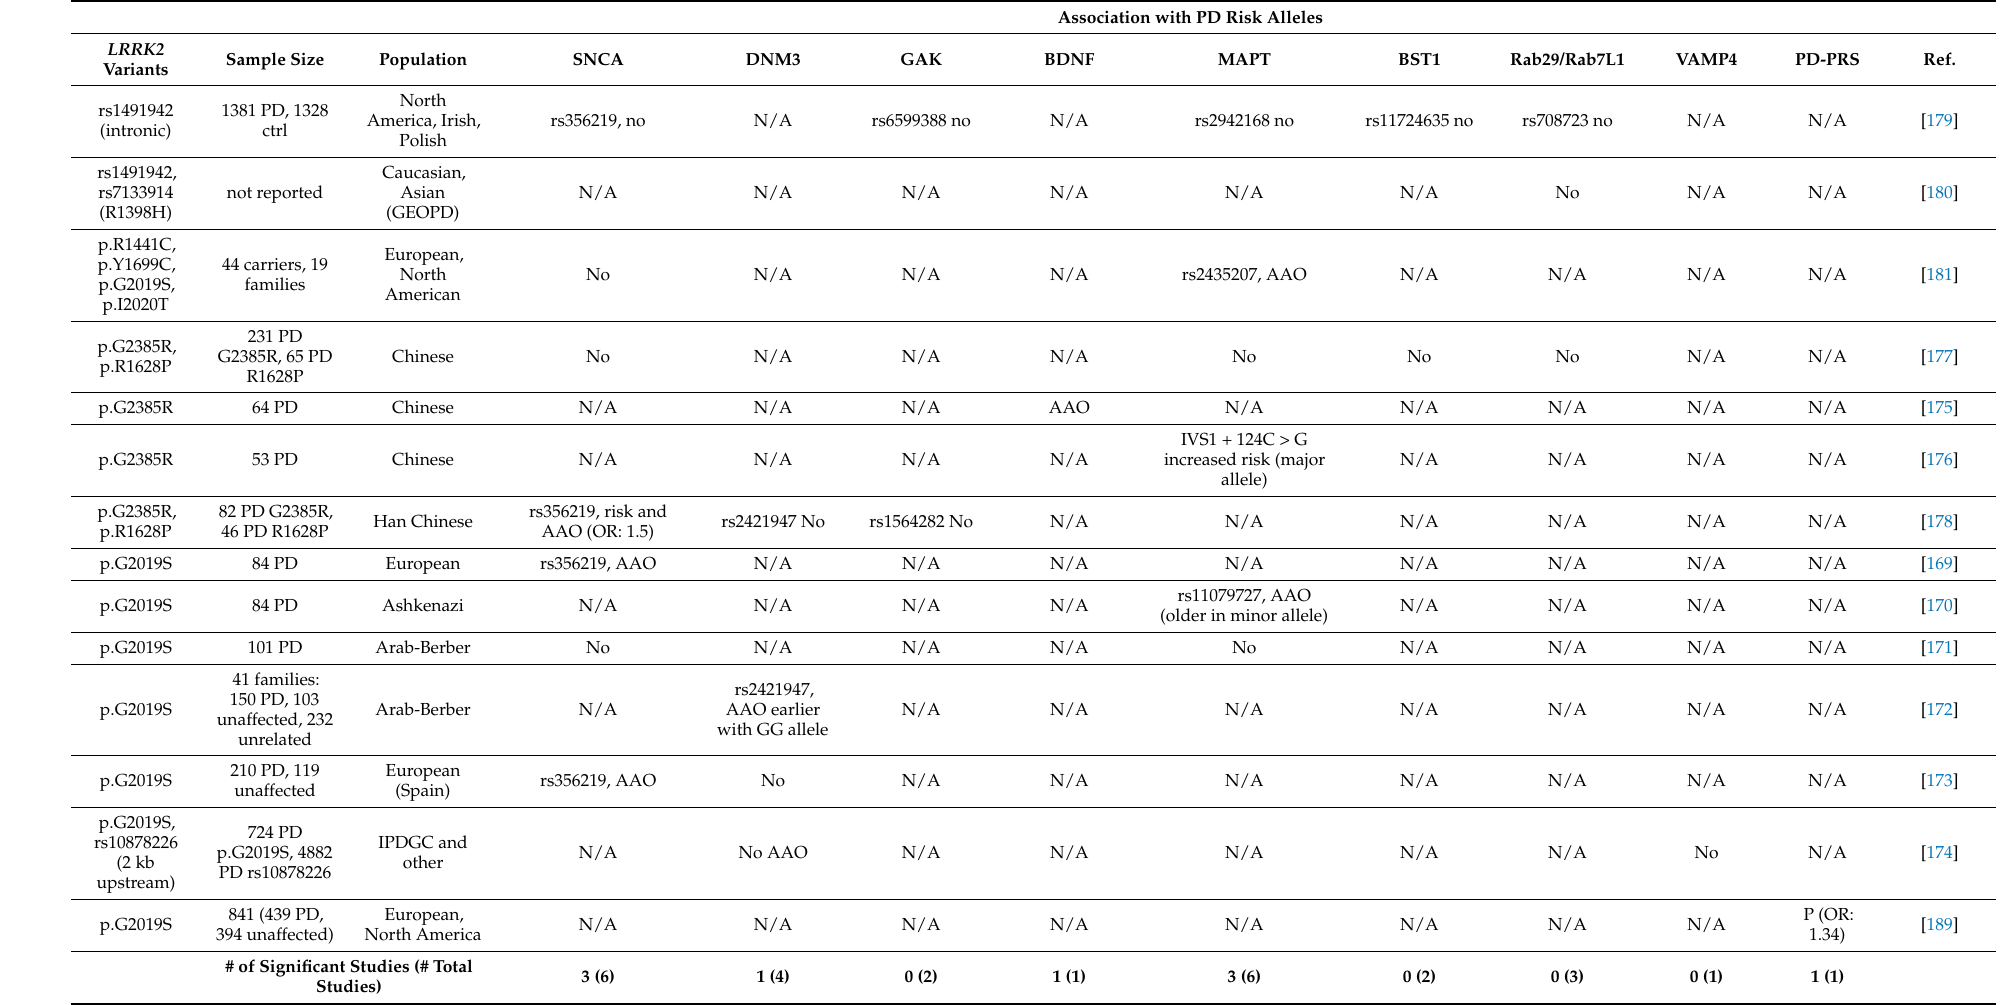
Table 3. Genetic modifiers of penetrance and age at onset in LRRK2